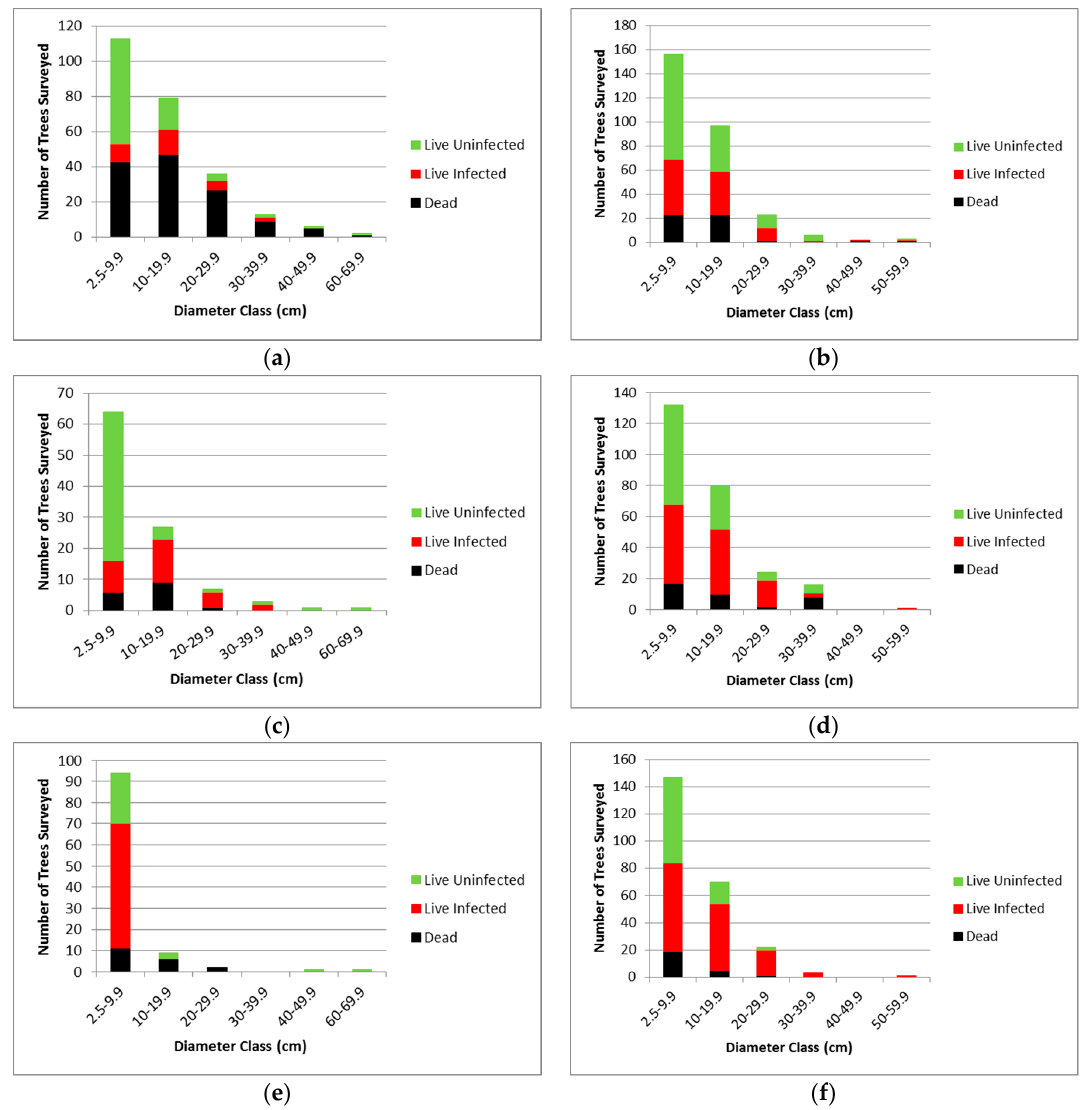
Figure 5. Number of whitebark pine trees surveyed by diameter class and health over the three survey periods: ( a ) Mount Rainier 2004, ( b ) North Cascades 2004, ( c ) Mount Rainier 2009, ( d ) North